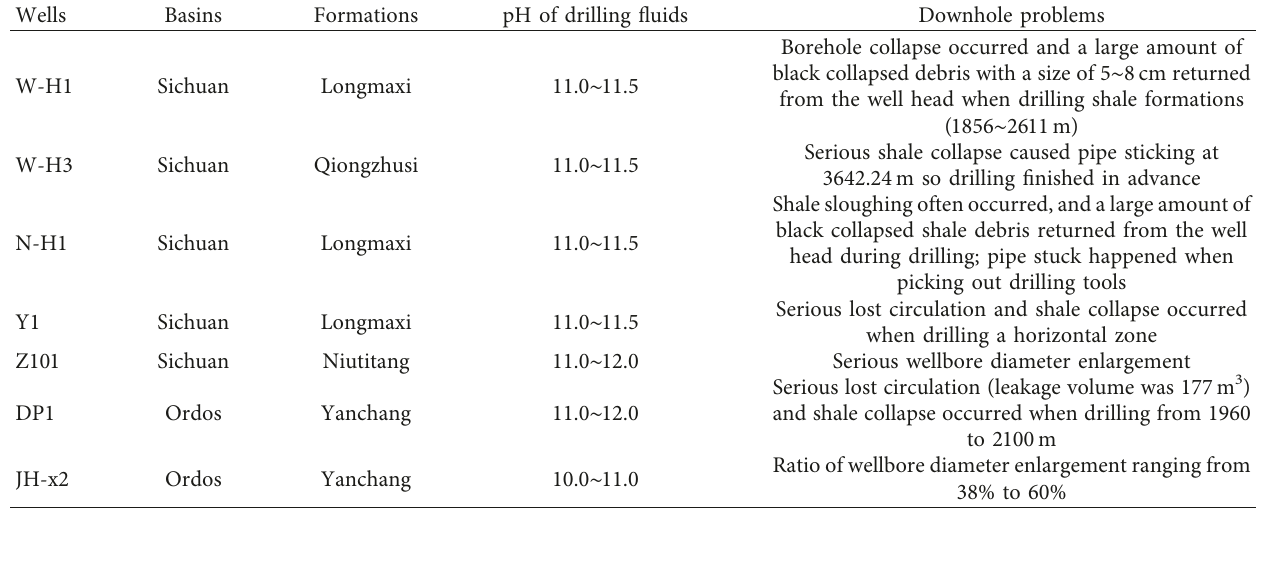
Table 1: Downhole problems during drilling shale wells in Sichuan Basin and Ordos